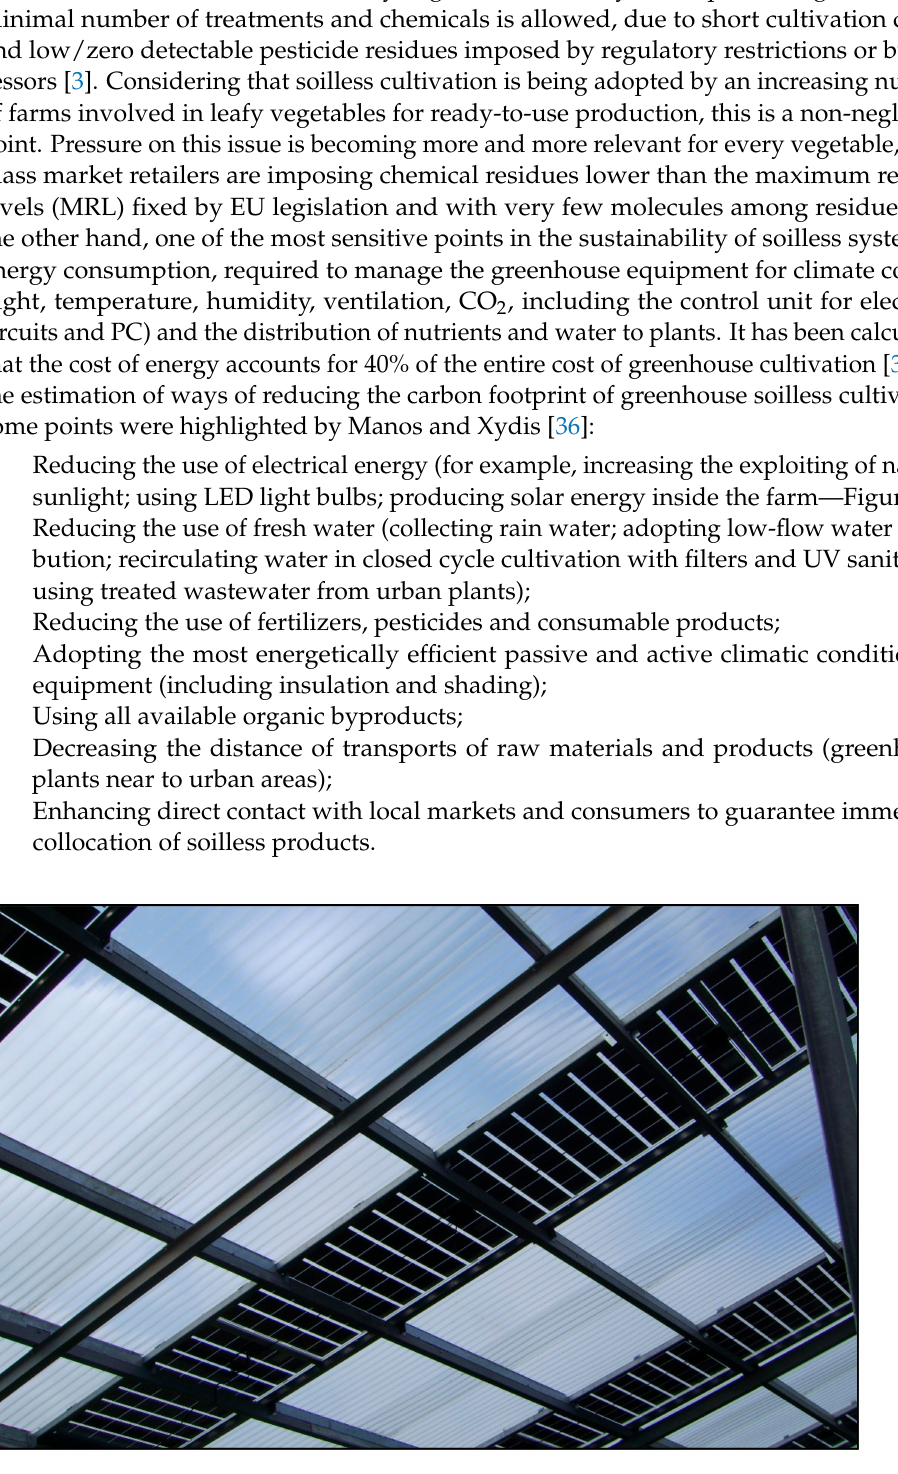
Figure 2. Example of producing solar energy inside the farm: innovative photovoltaic modules used as greenhouse cover material